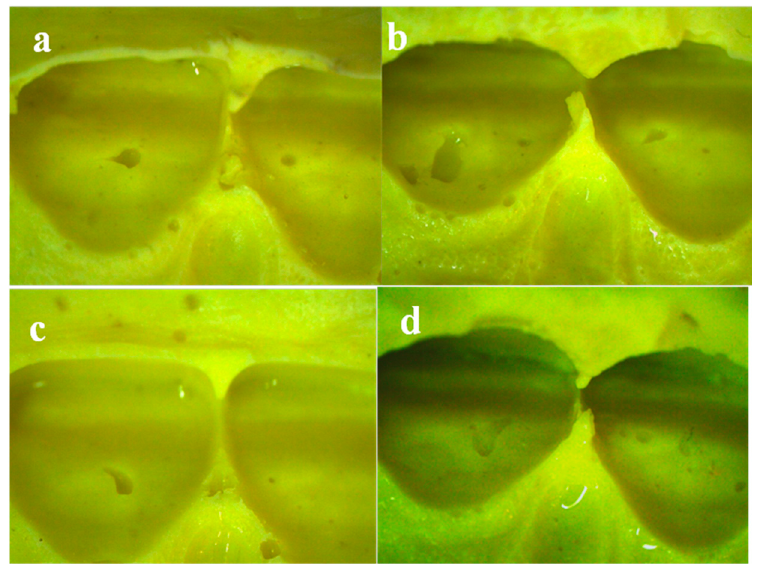
Figure 8. Stereomicroscopic images of clinical impression with proper interproximal contact, magnification 10×: ( a ) Group 1 (Algistar mixed as Manufacturer), ( b ) Group 2 (Algistar with ↑ Powder/water ratio, ( c ) Group 3 (Tropicalgin with ↓ Powder/water ratio), ( d ) Group 4 (Tropicalgin mixed as Manufacturer).